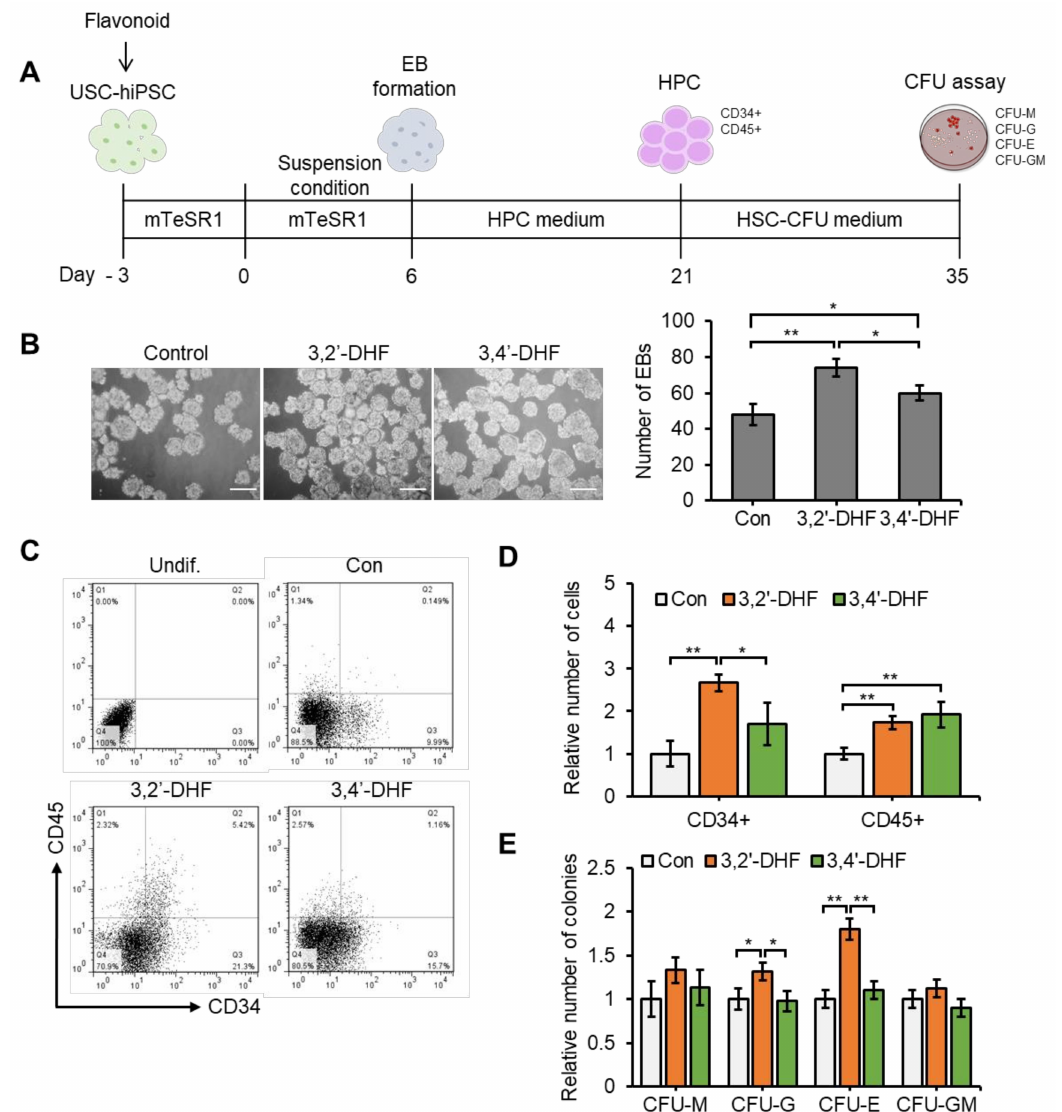
Figure 8. E ff ects of 3,2 (cid:48) -DHF and 3,4 (cid:48) -DHF on USC-iPSCs di ff erentiation to HPCs. ( A ) Schematic of the HPC di ff erentiation process. ( B ) E ff ects of 3,2 (cid:48) -DHF and 3,4 (cid:48) -DHF on USC-iPSC EB formation. ( C ) Representative flow cytometry dot plots of the hematopoietic markers observed during hiPSC di ff erentiation of the control and 3,2 (cid:48) -DHF- and 3,4 (cid:48) -DHF-treated cells. ( D ) Relative number of CD34 + and CD45 + cells during hematopoietic di ff erentiation. The data are presented as fold changes compared with the Con group. ( E ) Colony forming unit (CFU) potential of control, 3,2 (cid:48) -DHF- and 3,4 (cid:48) -DHF-treated USC-iPSCs. The data are presented as fold changes compared with the Con group. n = 3 biological samples. (* p < 0.05, ** p < 0.01, *** p <